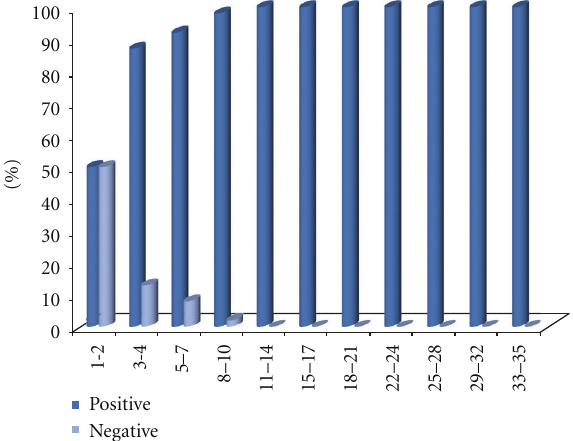
Figure 1: Frequencies of positive and negative culture in di ff erent days. Table 2: Number and kind of bacteria was identified from 164 patients in first hours and other weeks.